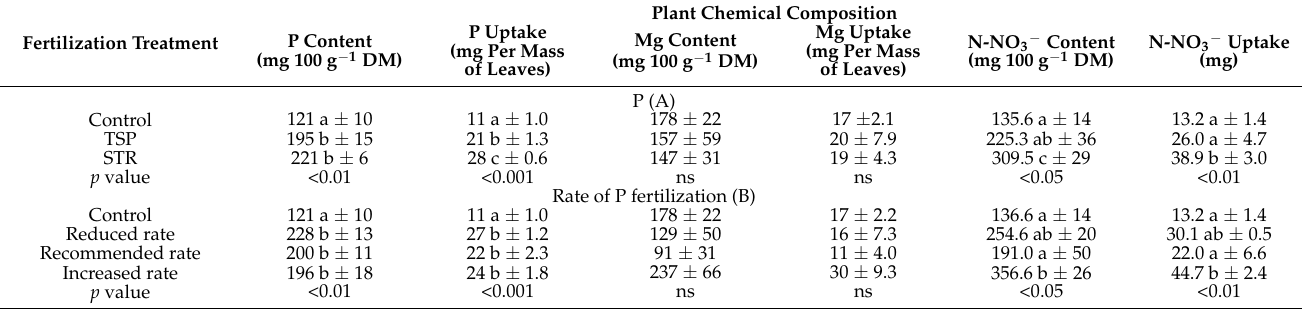
Fertilization Treatment Table 3. Effect of TSP and STR fertilization on P, Mg and N-NO 3 − content and uptake by butterhead lettuce.